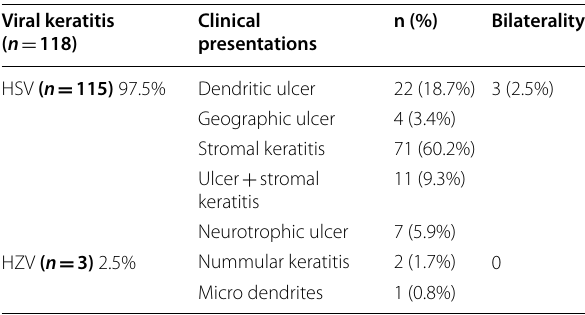
Table 7 The distribution of different clinical presentations of viral keratitis Viral keratitis ( n